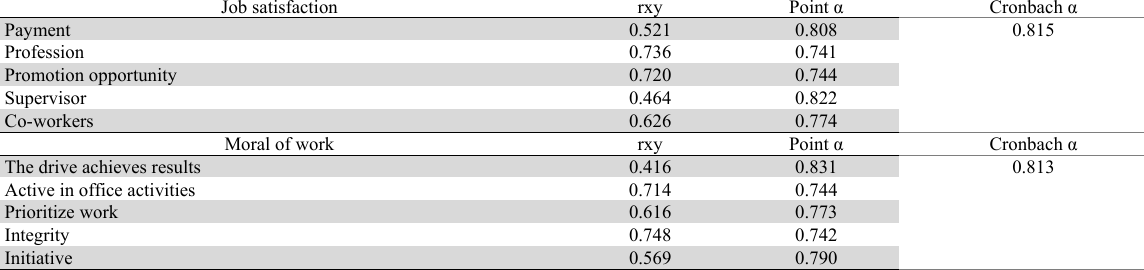
Test the validity of the intervening and dependent variables